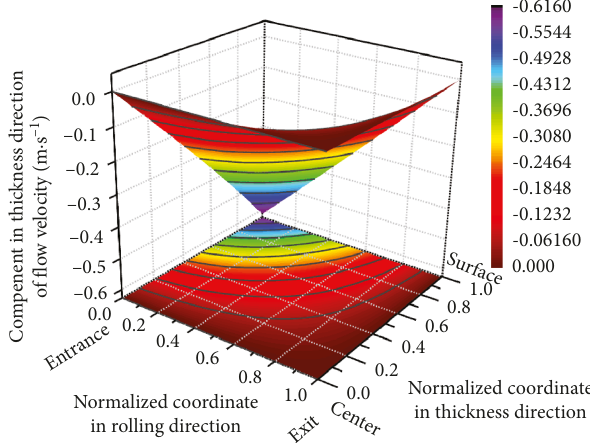
Figure 7: Distribution of flow velocity in thickness direction with H � 0.5m, h � 0.46 m, R � 0.3m, and v